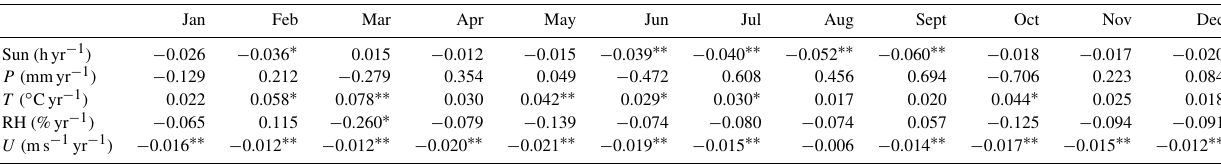
Table 1. Inter-annual trends of monthly sunshine duration (Sun), precipitation ( P ), air temperature ( T ), relative humidity (RH), and wind speed ( U ).